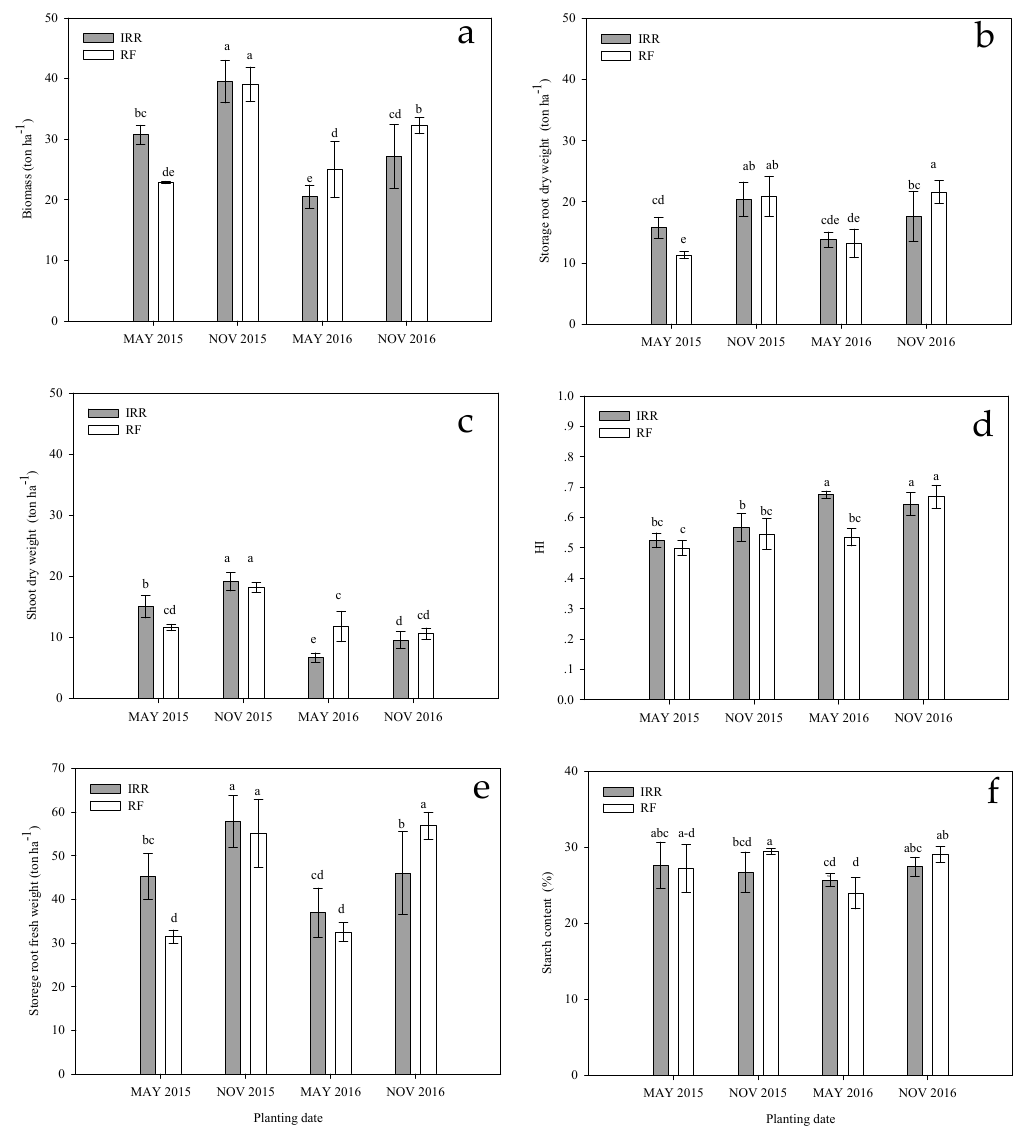
Figure 2. ( a ) Biomass; ( b ) storage root dry weight; ( c ) shoot dry weight; ( d ) harvest index (HI); ( e ) storage root fresh weight; and ( f ) starch content of Rayong 9 cassava genotype under irrigated and rainfed conditions at harvest (12 MAP), planting in May and November for two years. The bar is standard deviation.